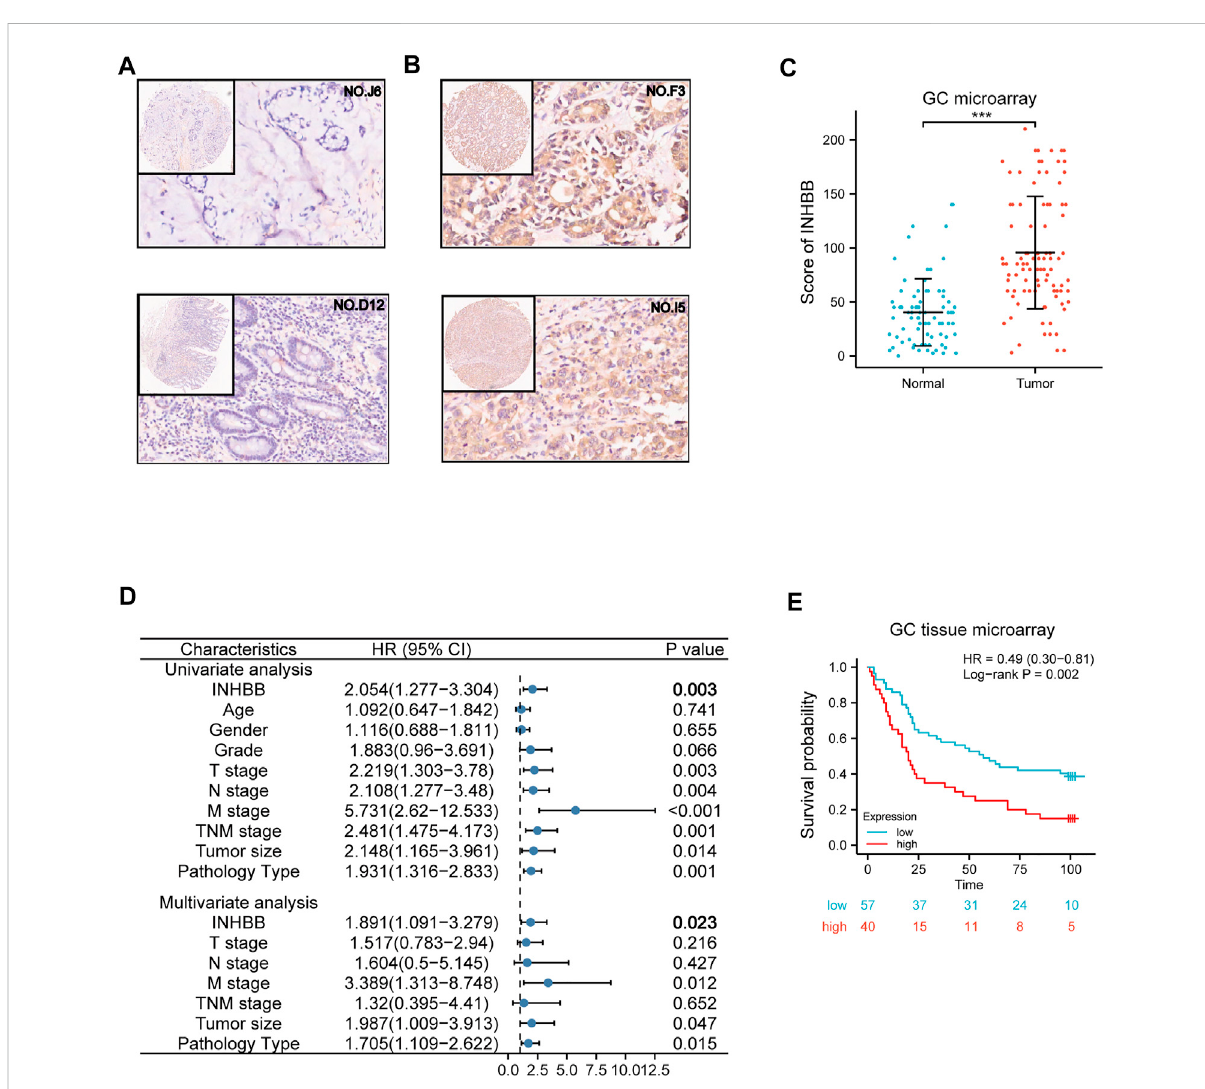
FIGURE 5 Validation of the role of INHBB in GC. (A) IHC of normal tissues (4X and 20X scopes), (B) IHC of GC tissues (4X and 20X scopes), (C) differential expression of INHBB in GC tissues and normal tissues, (D) Cox regression analysis of INHBB and clinical features in GC, (E) Kaplan-Meier survival analyses of INHBB in GC patient data form GC tissue